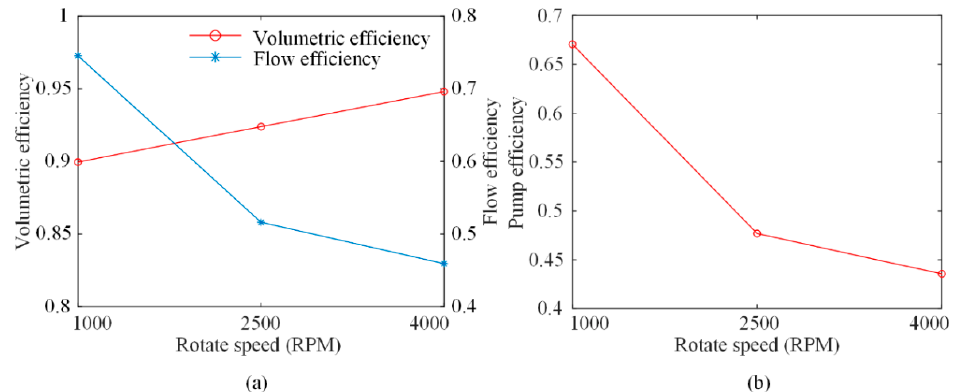
Figure 17. Efficiencies of the Roots pump under various rotational speeds. ( a ) volumetric efficiency and flow efficiency; ( b ) pump efficiency.